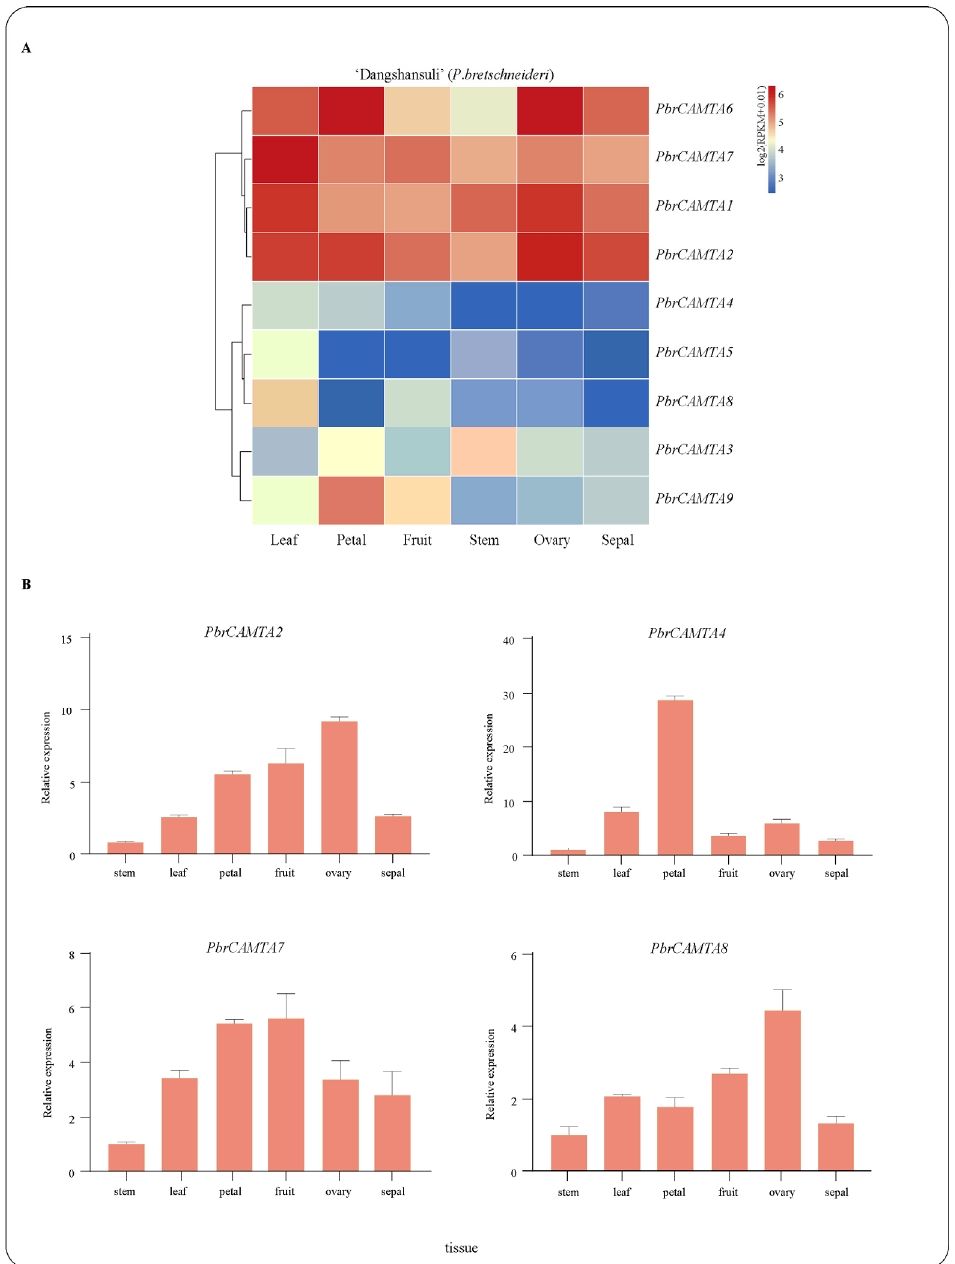
Figure 6. Heatmap and qRT-PCR analysis of expression levels of PbrCAMTA genes in tissues. ( A ) Heatmap of the expression level (log 2 (RPKM+0.01)) of nine PbrCAMTA genes in six different tissues (leaf, petal, fruit, stem, ovary, and sepal) in ‘Dangshansuli’. The heatmap is plotted by pheatmap; red indicates high expression, and blue indicates low expression. The color scale at the top right represents RPKM values normalized by log2. ( B ) qRT-PCR analysis of four PbrCAMTA genes in six different tissues. The x-axis represents six different tissues (stem, ovary, petal, sepal, fruit, and leaf), and the y-axis represents relative expression levels of the PbrCAMTA genes. Error bars indicate three technical replicates derived from one bulked biological replicate.